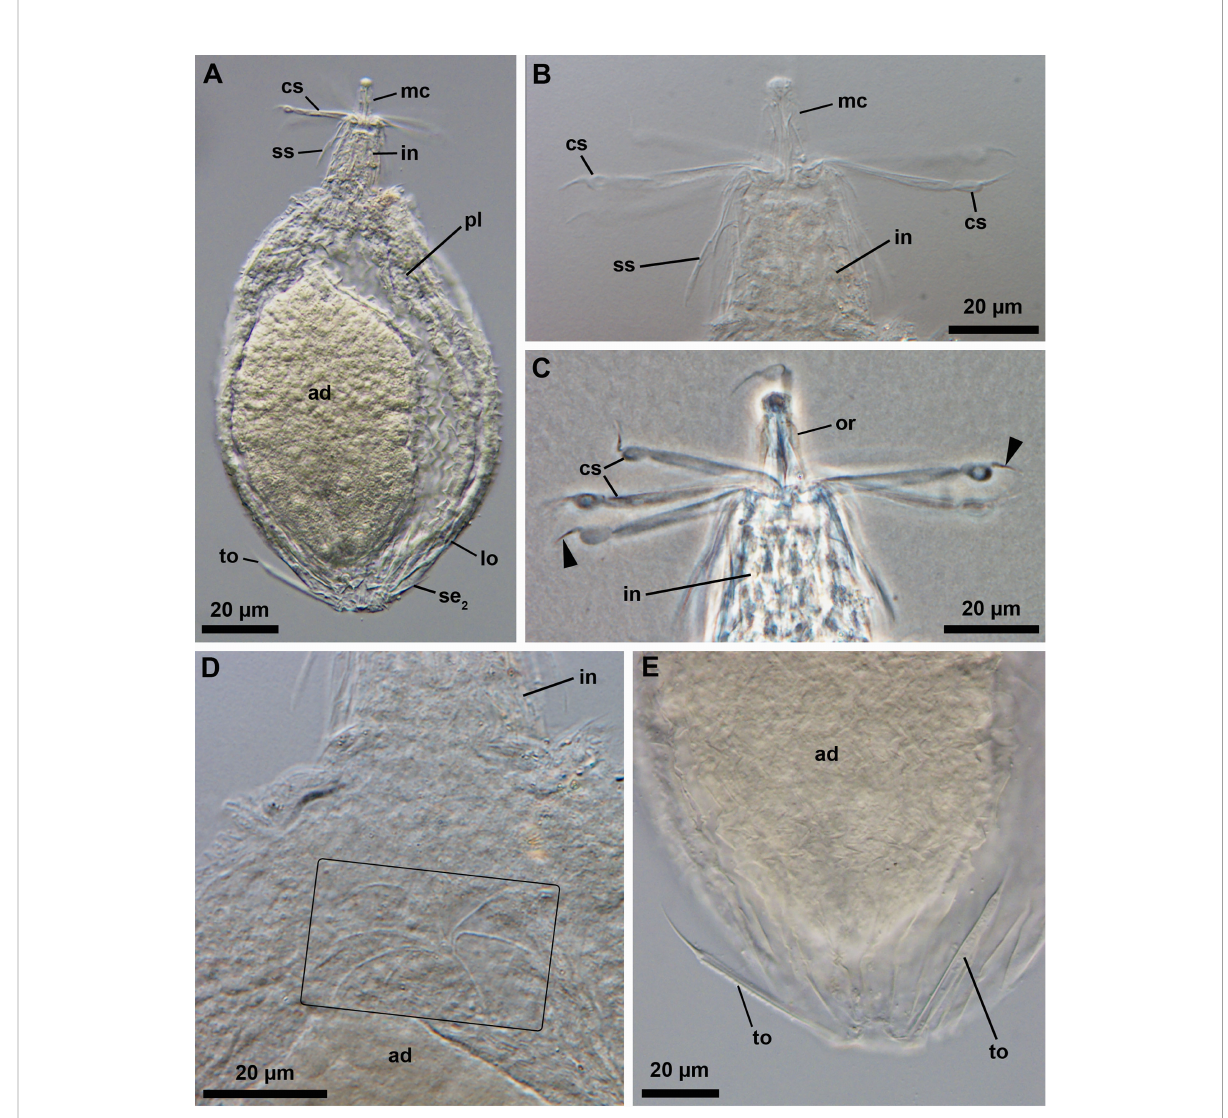
FIGURE 4 Light micrographs of the last instar Higgins larva (carrying a postlarva and a young adult inside) of an undescribed genus (NHMD-621042). (A) Overview. Ventral view, anterior faces up. (B, C) Anterior region of the body. The arrowhead points to the spine-like distal segment of the three- segmented clavoscalids. (D) Close-up of the abdominal region of the body. The rectangle outlines the ruff of the adult enclosed within the larval and postlarval body. (E) Close-up of the posterior region of the body. Abbreviations: ad, adult; cs, clavoscalids; in, introvert; lo, lorica; mc, mouth cone; or, oral ridge; pl, postlarva; se 2 , posterolateral seta; ss, spinoscalid; to,